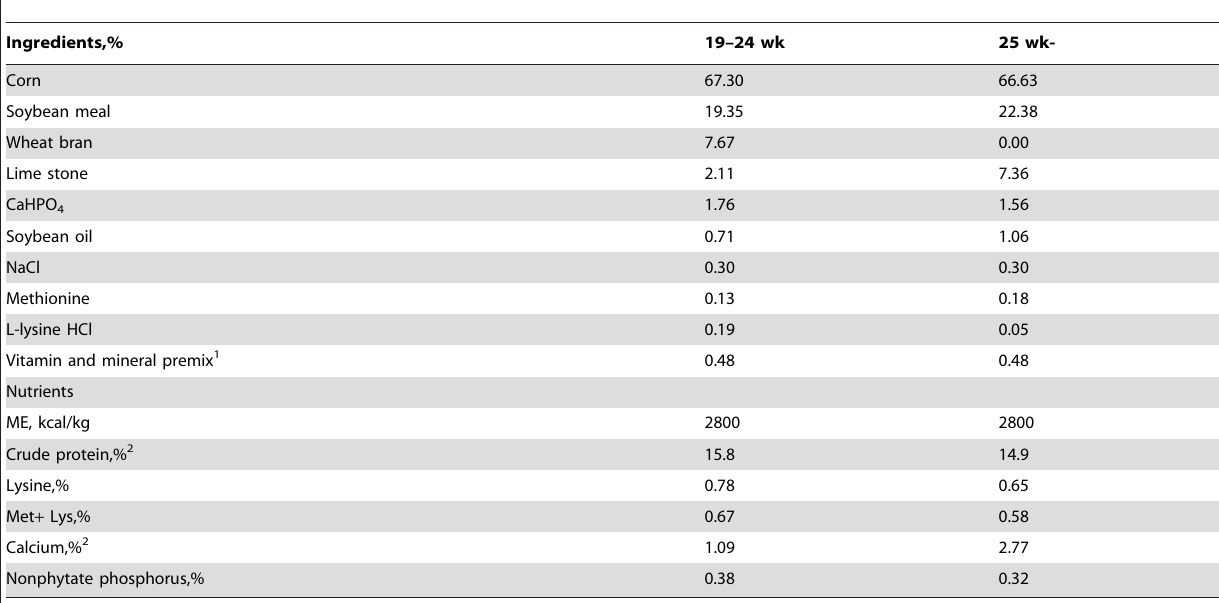
Table 1. Composition of diets fed to laying broiler breeder chickens.